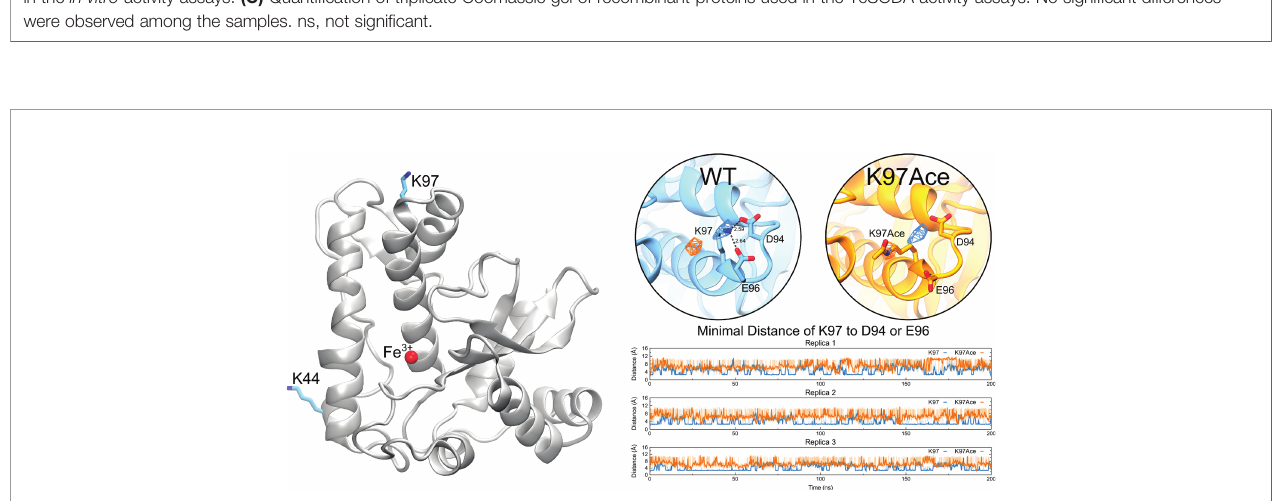
FIGURE 7 | MD simulations reveal that K97 acetylation affects the salt-bridge pattern of TcSODA. Left, TcSODA structure as cartoon, highlighting the position of K97 residue and Fe 3+ , shown as cyan sticks and as a red sphere, respectively. Right, the orientation of K97 with respect to D94 and E96 in native (WT, in cyan) and acetylated (K97Ace, in orange) TcSODA, measured by the occupancy of the sidechain nitrogen atom of K97, showing that K97 is kept near these acidic residues whereas acetylation repeals it. This spatial change of K97 alters the salt-bridge formation between such residues, as shown by minimal distance measurements in all